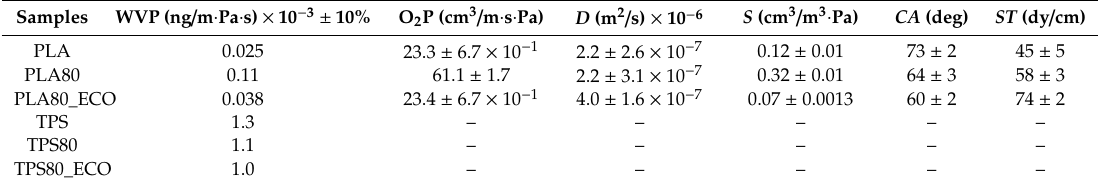
Table 4. Water vapor permeability (WVP), oxygen permeability (O 2 P), di ff usion coe ffi cient (D), solubility coe ffi cient (S) measured at 25 ◦ C and 50% relative humidity, contact angle ( CA ), and surface tension ( ST ) of PLA / TPS-based